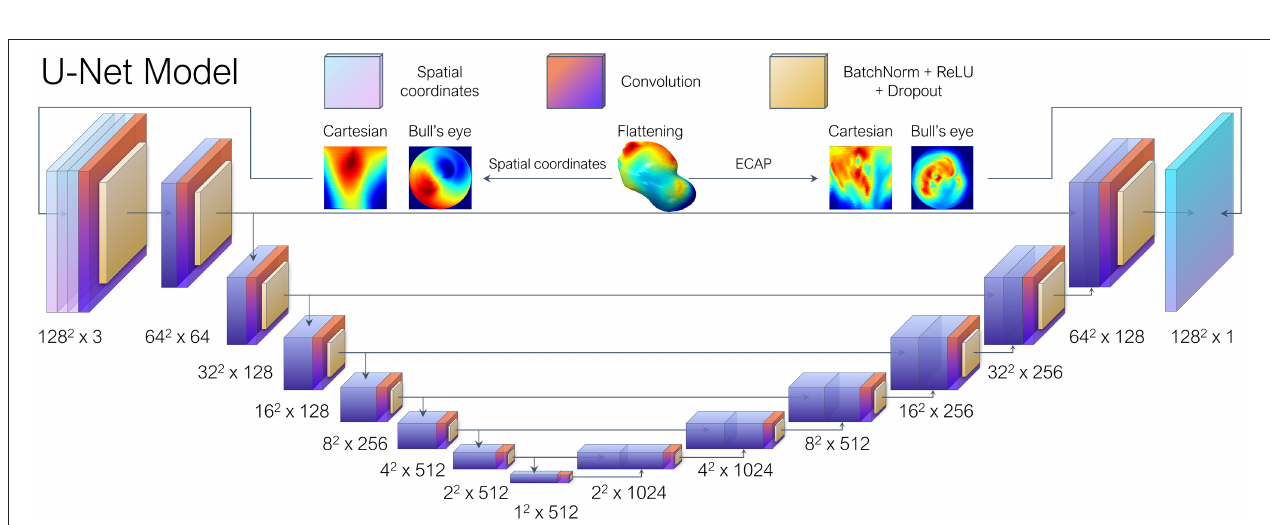
FIGURE 2 | (A) Scheme of the principal component analysis model (PCA). Once each shape was parameterized, the ECAP values were predicted through a simple multilayer perceptron formed by fully connected layers (FCN). Numbers below each layer represent the number of nodes in each of them. (B) The LAA morphology is flattened to a new 2D UV space in which the new axes are represented by the geodesic apical-ostium distance and the angle formed with respect to the centroid of each isoline, using the closest point to the circumflex artery as reference. ECAP, endothelial cell activation potential.